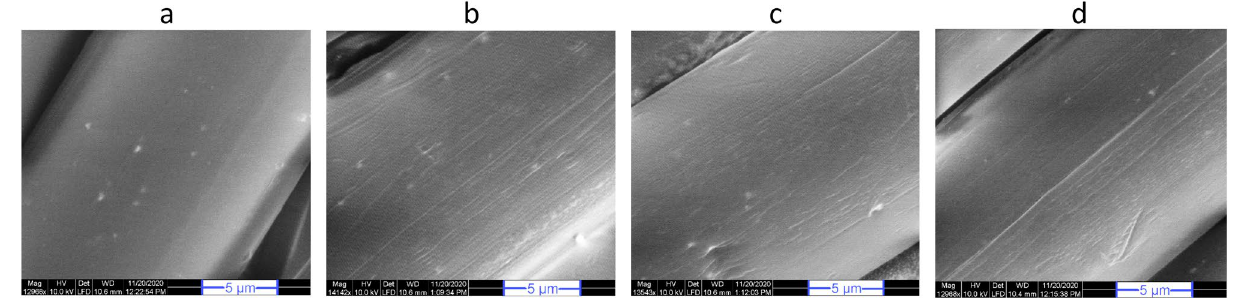
Figure 1. SEM images of polyamide fabrics; ( a ) untreated and plasma treated with ( b ) oxygen, ( c ) nitrogen and ( d ) oxygen +